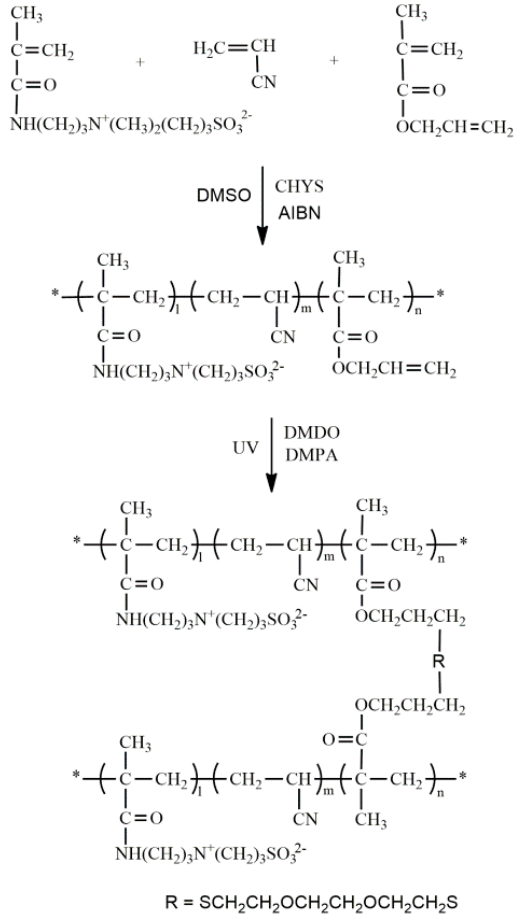
Figure 1. Scheme for the synthesis of P(AN-co-SBMAA-co-AMA). The “*” represent the polymer chain terminal groups.